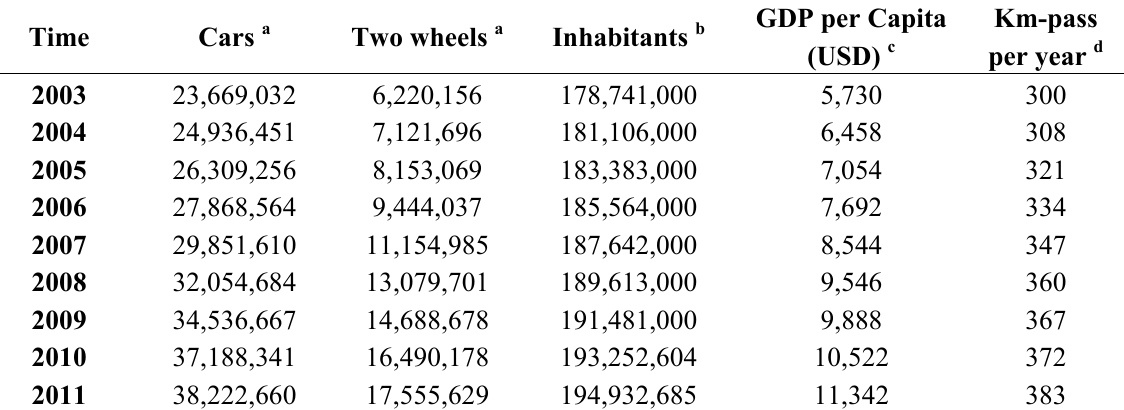
Table A1. Brazilian data and the PKM demand.